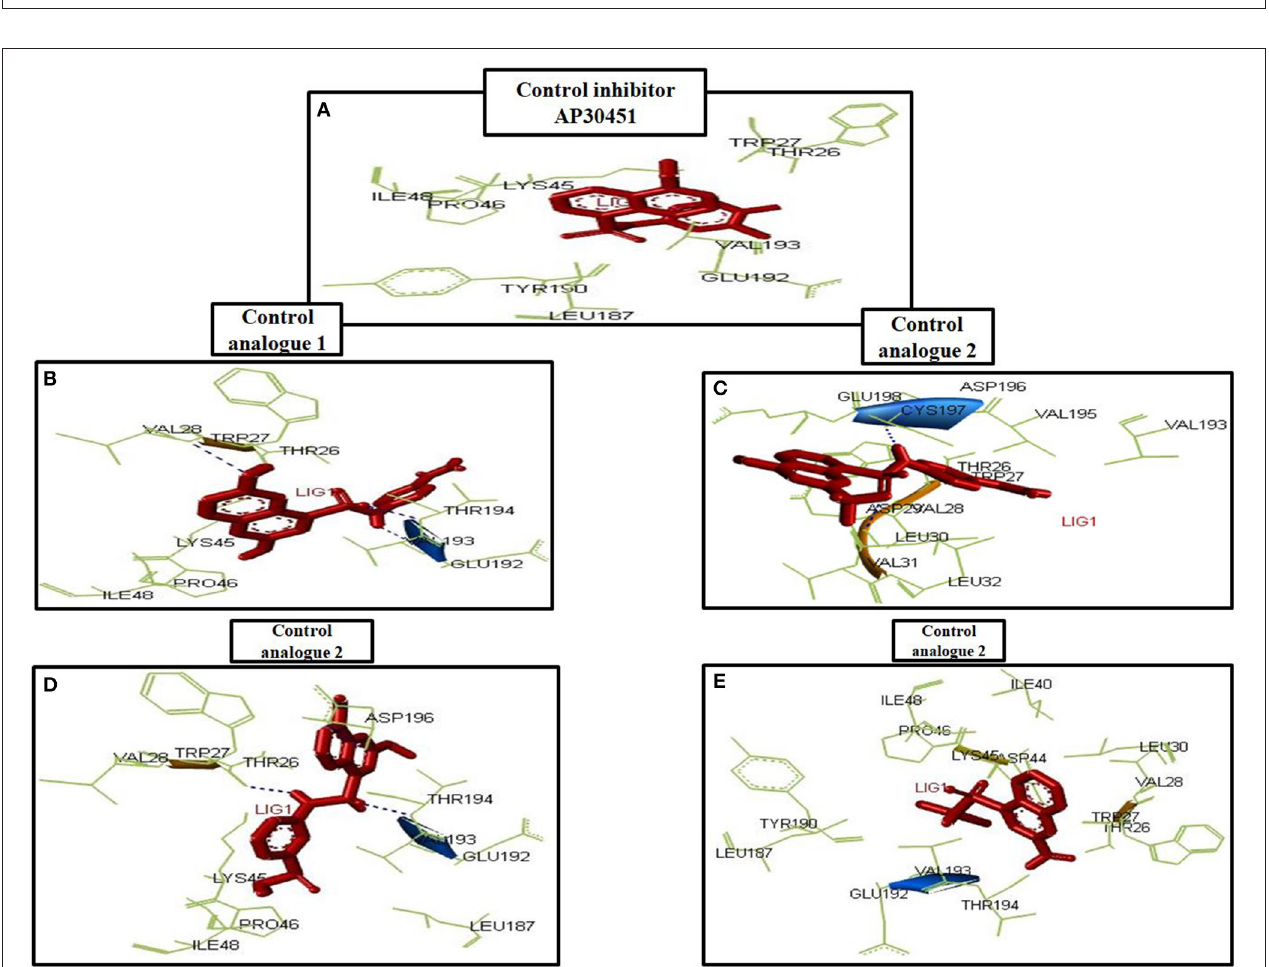
Frontiers in Chemistry |